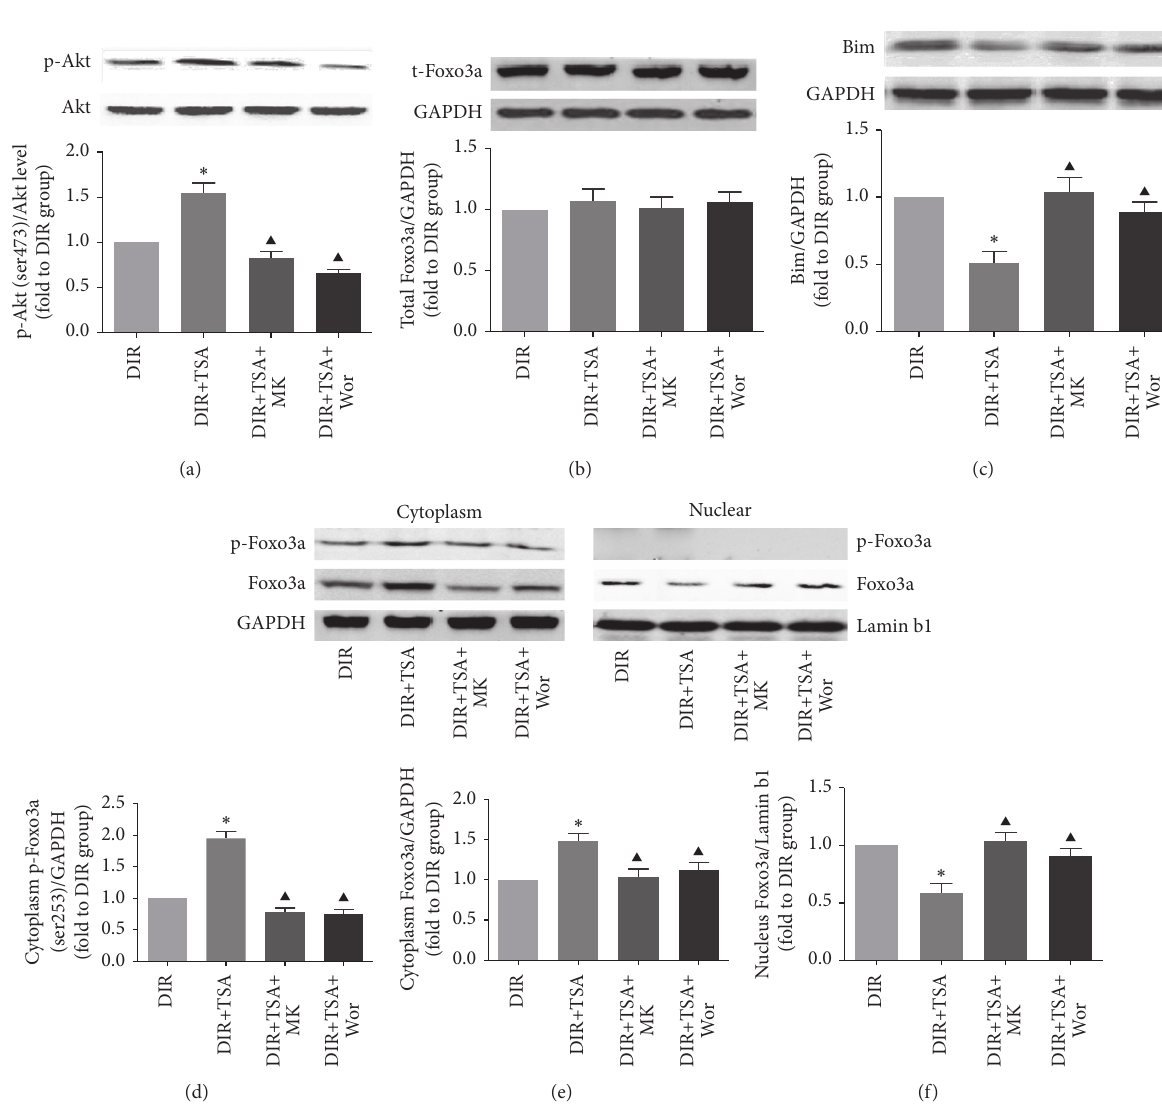
Figure 5: Expressions of p-Akt, p-Foxo3a, and Bim. Representative myocardial p-Akt, total-Akt (a), total-Foxo3a (b), Bim (c), cytoplasm p-Foxo3a (d), cytoplasm Foxo3a (e), and nuclear Foxo3a (f) Western blots images and protein levels analysis. GAPDH or Lamin b1 served as the loading control. All values are presented as the mean ± SEM, 𝑛 = 6 /group. ∗ 𝑝 < 0.05 versus DIR group. 󳵳 𝑝 < 0.05 versus DIR+TSA